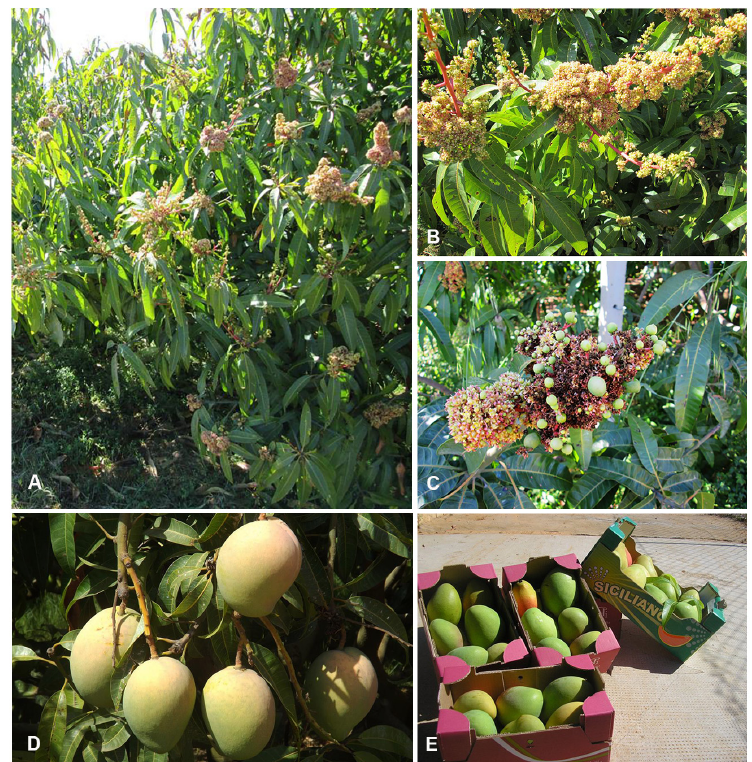
Figure 3. Sicilian mango plants and fruits. ( A ) Kensington Pride tree plantation in the province of Palermo (Balestrate). ( B ) Typical panicle inflorescence that stems at the apex of the branches carrying leaves and flowers. ( C ) Details of mango fruits growing on the inflorescence, the terminal shaped panicle. ( D ) Mango fruits of Kensington Pride variety from Balestrate cultivated land. ( E ) Sicilian mango fruits ready for the market. All pictures in the figure were provided by Ing. Luigi Martino.